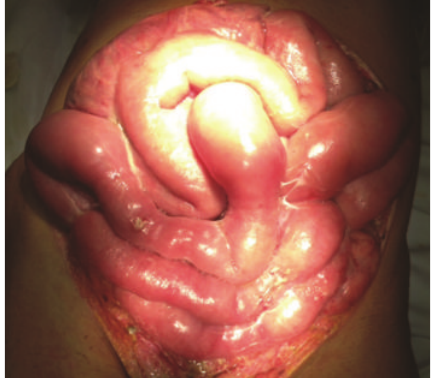
Figure 4: Depicts complete resection of the rectus abdominal muscles and fascia—20 × 25 cm open anterior abdominal defect on postoperative day number 20.